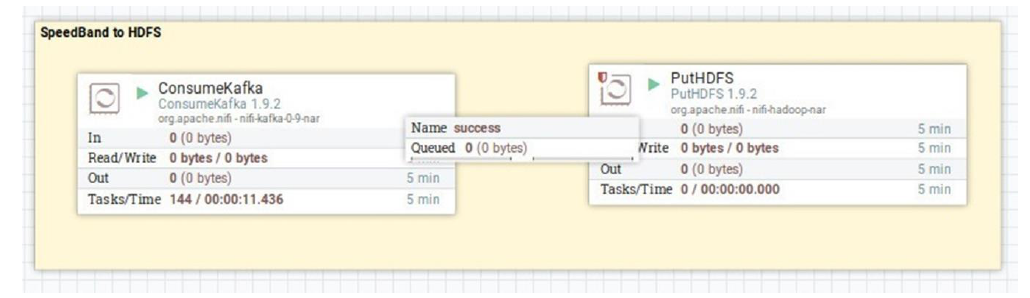
Figure 8. Data ingestion of MOBDA: Consumption of speedband data from Kafka to storage.